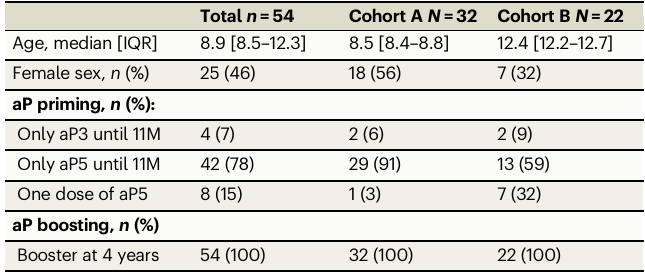
and N =22 individuals for cohort B. Sample means with 95% con fi dence intervals (solidblackpointandline)areplotted,andforthesigni fi cantdifferences,log2fold changes are depicted in the fi gure. Kruskal – Wallis followed by Wilcoxon rank-sum test was usedto compare across cohorts.* p ≤ 0.05, p =0.014 forIgG and p =0.024 for